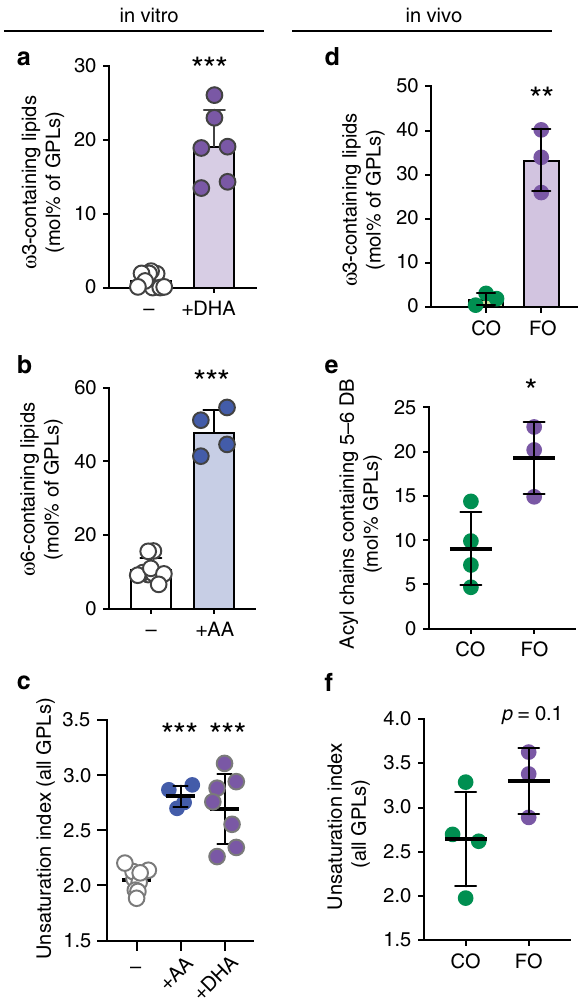
Fig 1 Supplemented PUFAs are robustly incorporated into membrane phospholipids in vitro and in vivo. Supplementation of culture media with PUFAs for 3 days (20 μ M) leads to a dramatic increase in ( a ) ω − 3 PUFA- containing membrane lipids in RBL cells supplemented with DHA and ( b ) ω − 6 PUFA-containing membrane lipids supplemented with AA. ( c ) Both treatments result in signi fi cantly increased overall unsaturation of membrane lipids. The unsaturation index re fl ects a concentration-weighted average lipid unsaturation. ( d ) Mice fed a diet rich in fi sh oil (FO) have signi fi cantly more lipids containing ω − 3 PUFAs compared to corn oil (CO) fed mice. ( e ) Incorporation of dietary ω − 3 PUFAs increases cardiac tissue lipids containing very highly unsaturated (5 or 6 double bonds) acyl chains, resulting in an ( f ) increase in the overall unsaturation of membrane glycerophospholipids. Individual experiments ( a – c ) or animals ( d – f ) are shown. Bars represent mean ± SD. ** p < 0.01, *** p < 0.001 for unpaired t test compared to untreated. Treatment with saturated (PA) or monounsaturated (OA) fatty acids in these conditions had no effect on the lipidome (see Fig. S2). Source data are provided as a Source Data fi